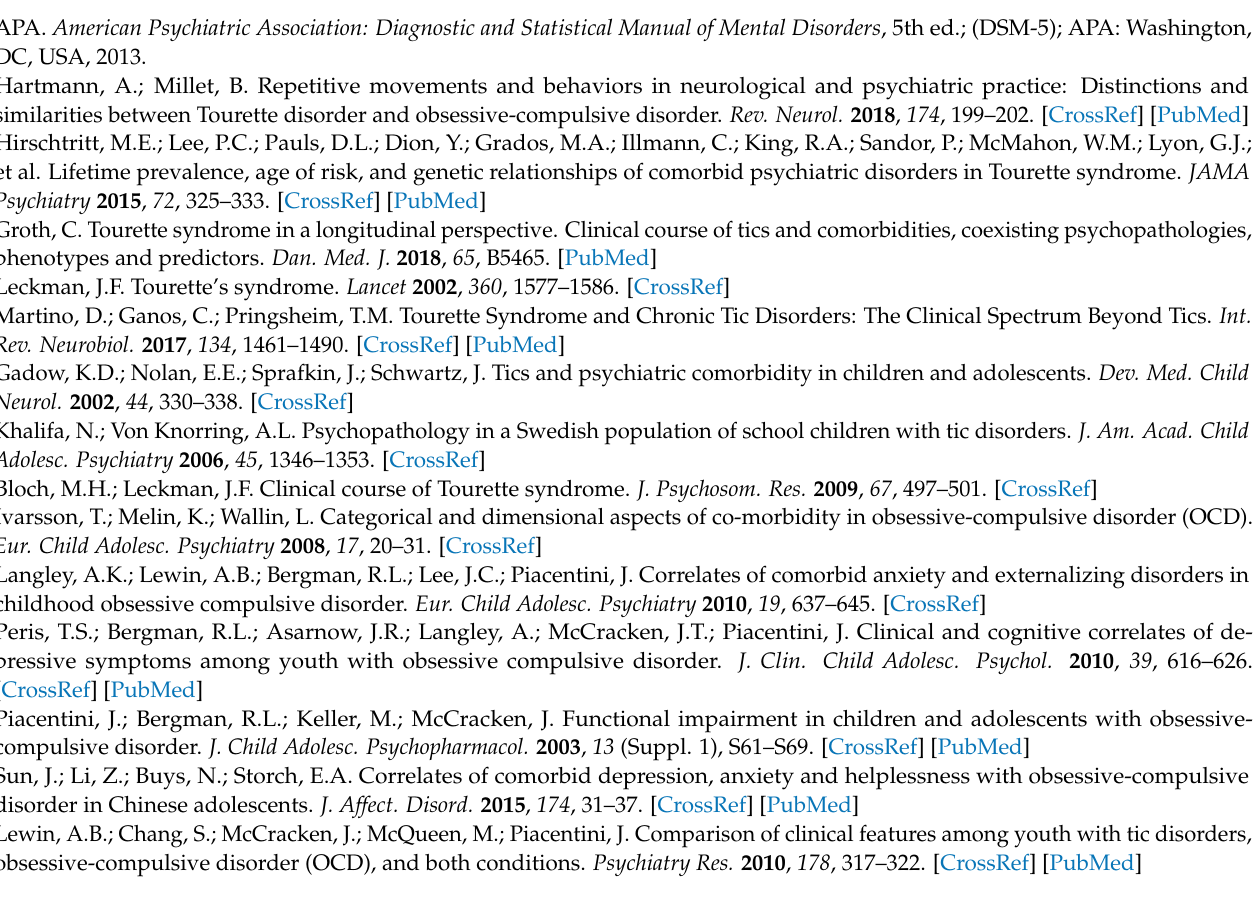
Figure S2: The Assessment procedure. Table S1: The descriptive statistic for the 8 syndromes of the CBCL for the whole sample; Table S2: The number of different types of comorbidities for OCD. Reference [24,59] is cited in the supplementary